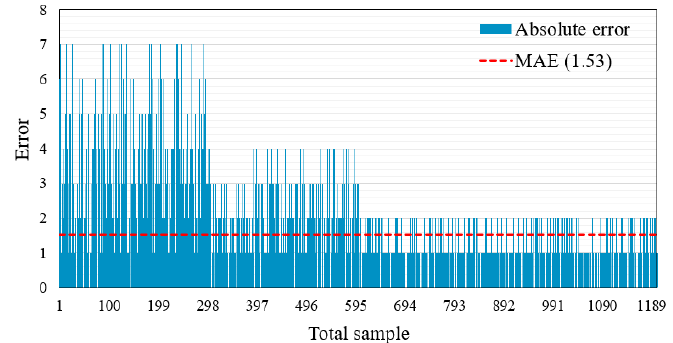
Figure 10. MAE measurements of the AWHMS. Table 3. Results of the error test.